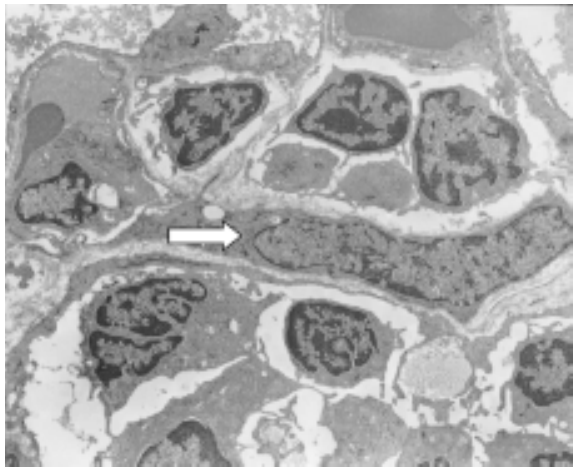
FIGURA 1 (cid:150) A fotoeletromicrografia mostra pleura visceral, macr(cid:243)fagos e fibroblastos (seta) (cid:150) ME 800